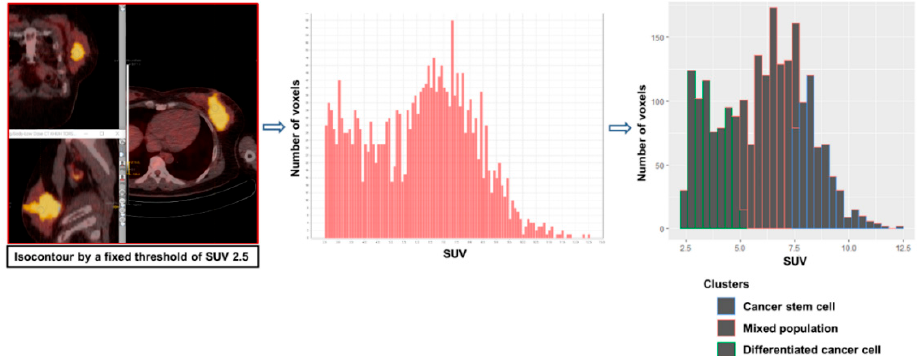
Figure 1. Workflow of measuring novel PET parameters for cancer stem cell metabolism.